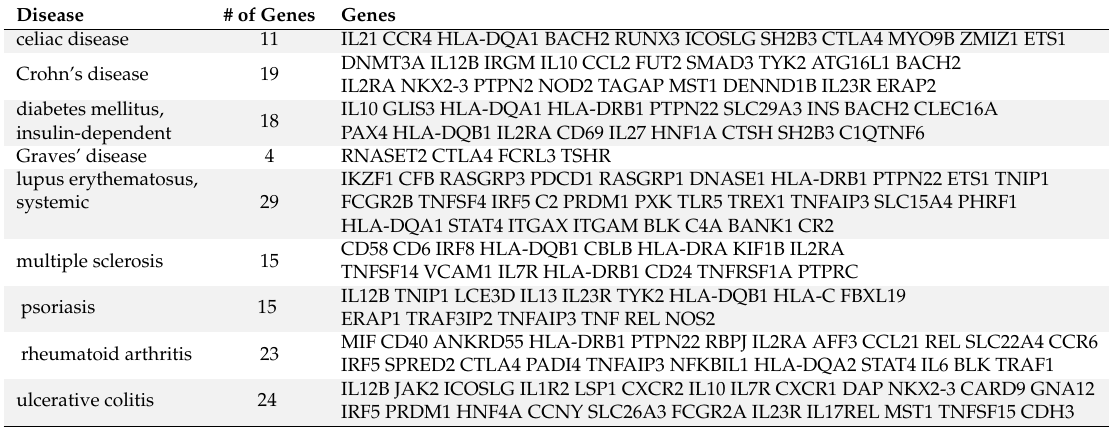
Table 4. Disease-gene associations for the nine autoimmune disorders used in this study.